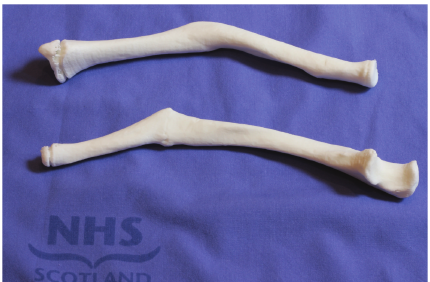
Figure 9: “Model” radius and ulna.